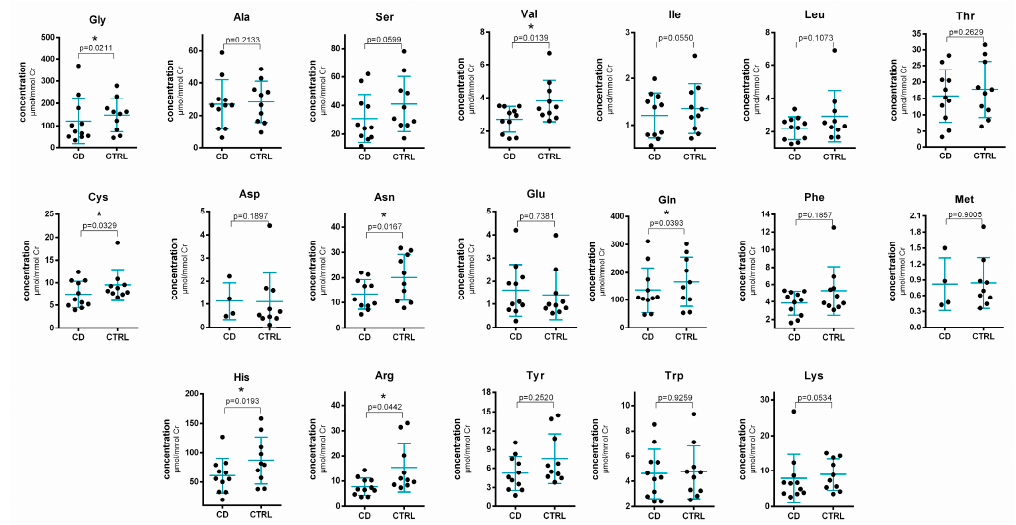
Figure 4. Statistical evaluation of the changes in amino acid concentrations in human urine samples obtained from inflammatory bowel disease (IBD) patients (CD) undergoing thiopurine treatment and from healthy control subjects (CTRL). For the sample preparation and other working conditions, see Section 3. The asterisk (*) indicates a statistical significance on the level p < 0.05. A moderate decrease of seven amino acids, namely Gly, Val, Cys, Gln, Asn, His, Arg, in IBD patients was observed. The concentration decrease was interpreted with significance p<0.05. Some of